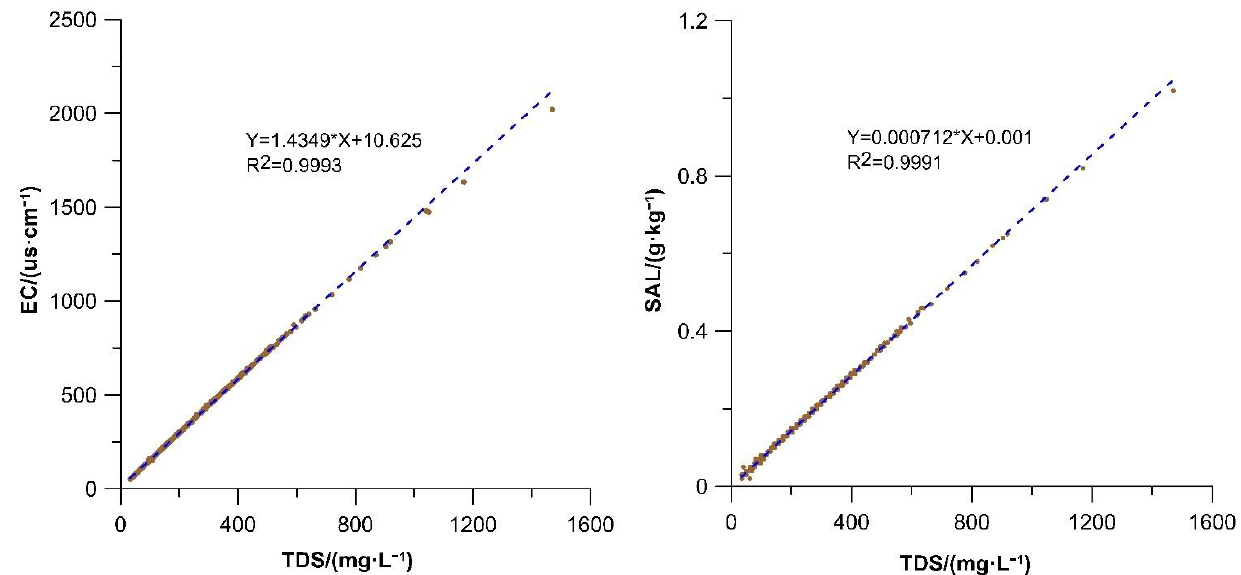
Figure 6. Correlation between TDS and EC, and TDS and SAL in sediment lixivium study section (blue dotted line is the trend line).